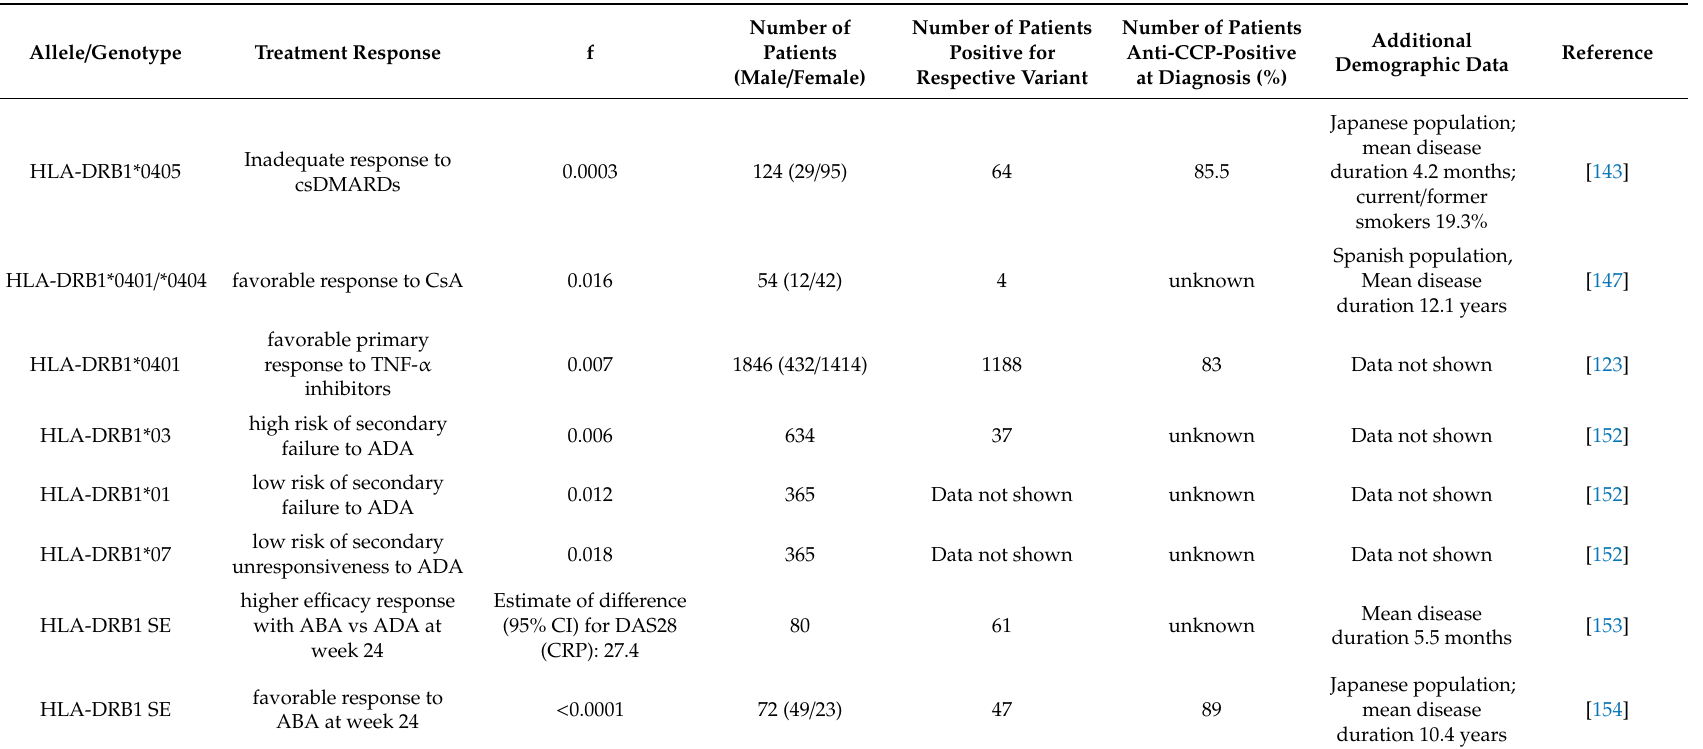
Table 3. Studied concerning associations between HLA-DRB1 and treatment